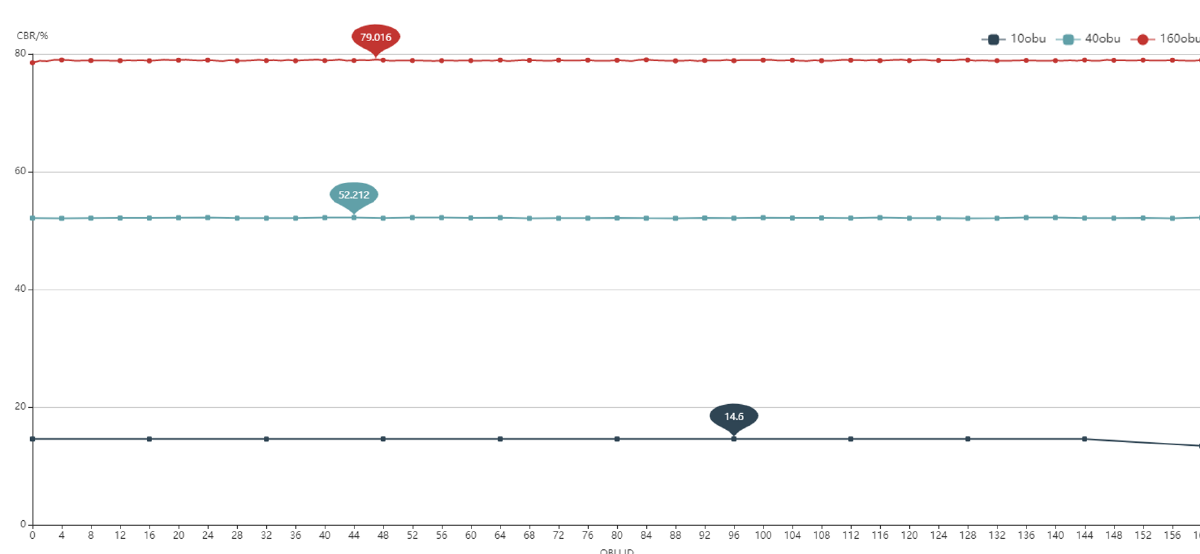
Figure 24. Large-scale test result (CBR with 10,40,160